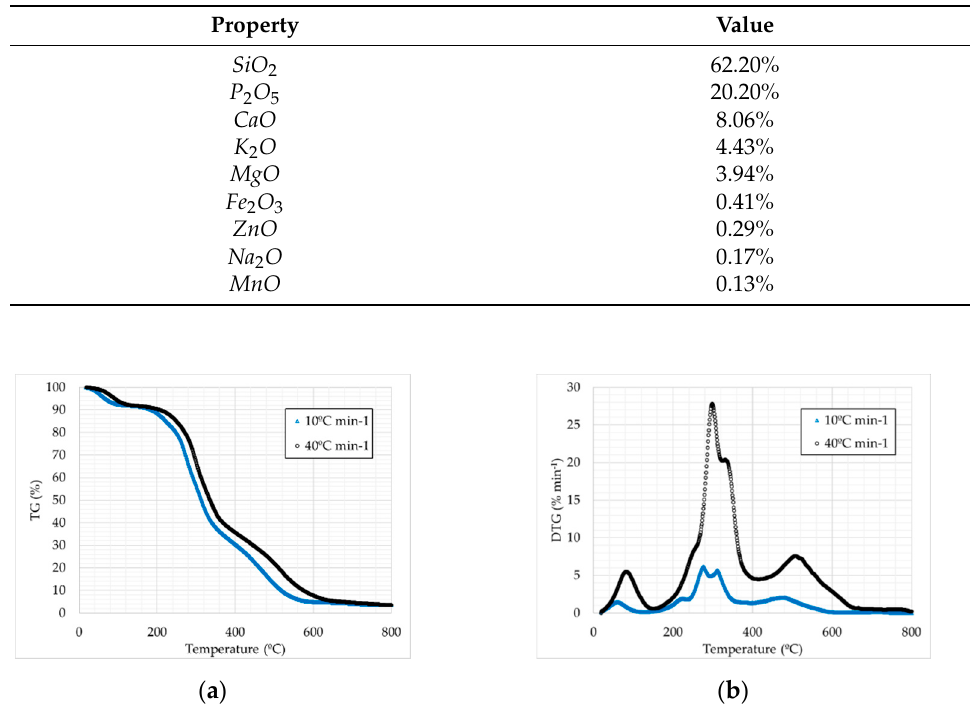
Table 3. Ash composition (% db).